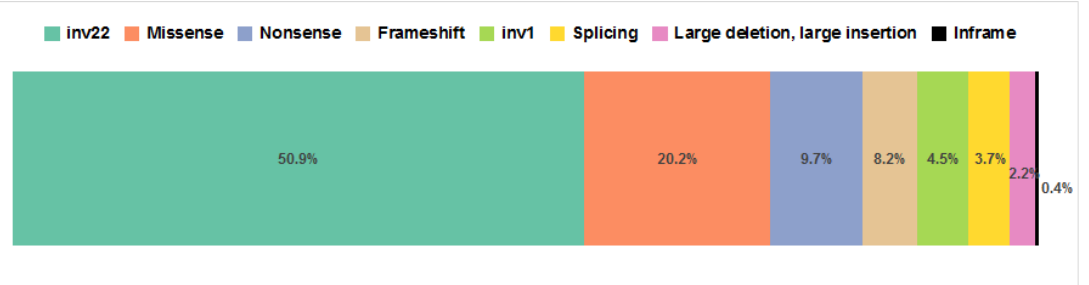
Figure 1. Proportions of different pathogenic variant types found among 267 patients from Russia.